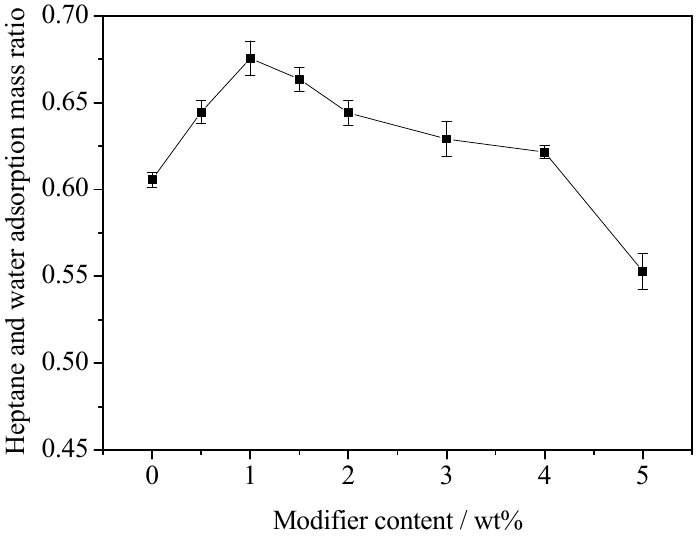
Figure 11. Heptane and water gas adsorption ratio vs. modifier content